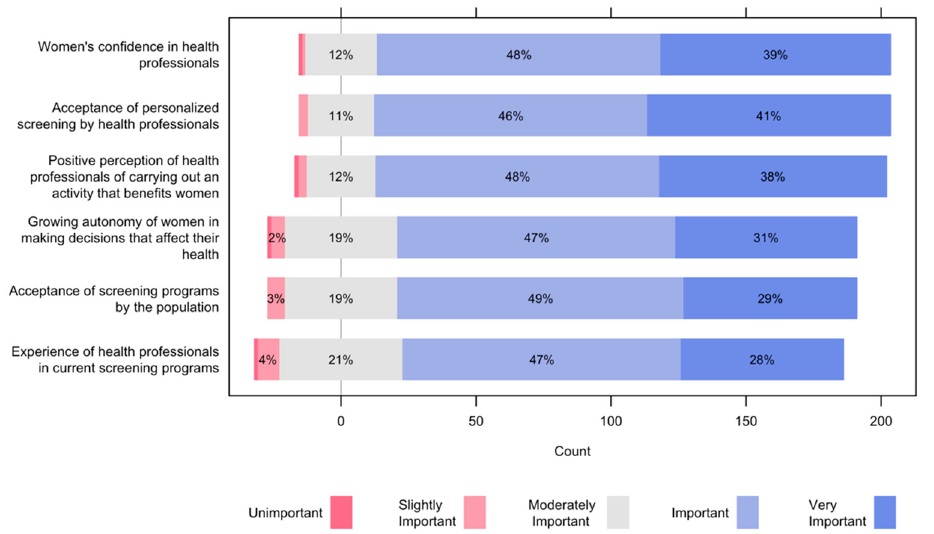
Figure 4. Facilitators for the implementation of a risk-based screening program.